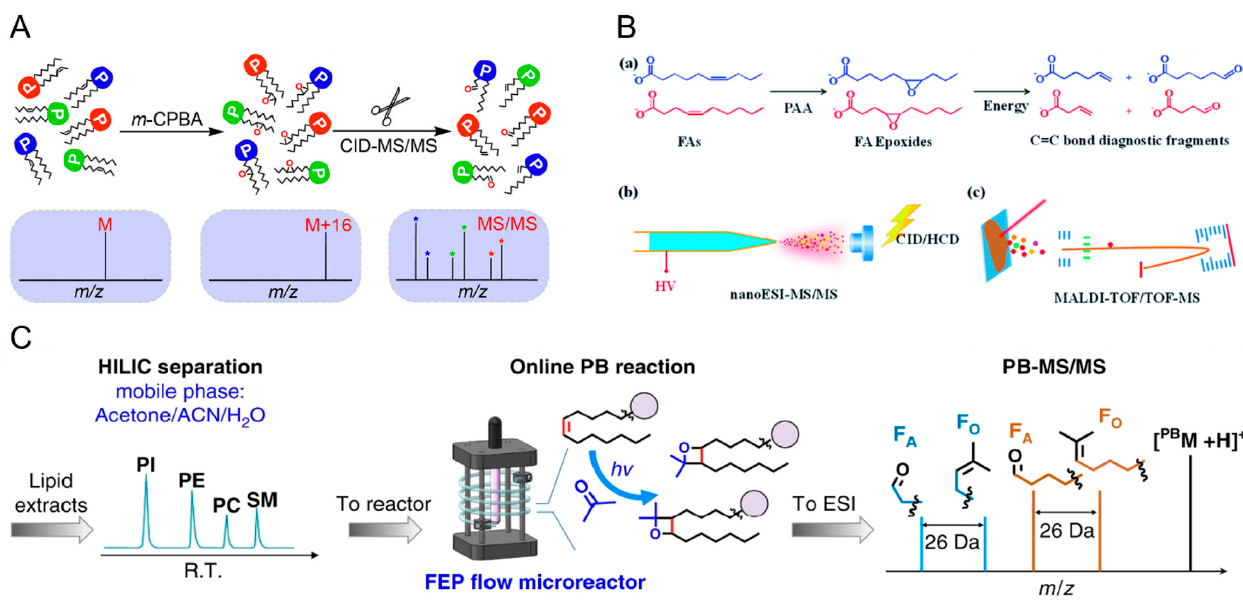
Figure 6. Lipid C=C bond localizations using ( A ) m -CPBA epoxidation [124], ( B ) PAA epoxidation [125], and ( C ) an online P-B reaction [126], followed by MS/MS for the structural elucidation of lipid isomers. FA, fatty acid, PI, phosphatidylinositol, PE, phosphotidylethanolamine, PC, phosphotidylcholine, SM, sphingomyelin, ACN, acetonitrile. Adjusted and reprinted with permissions from the American Chemical Society ( A ), the Royal Society of Chemistry ( B ), and Springer Nature ( C ).